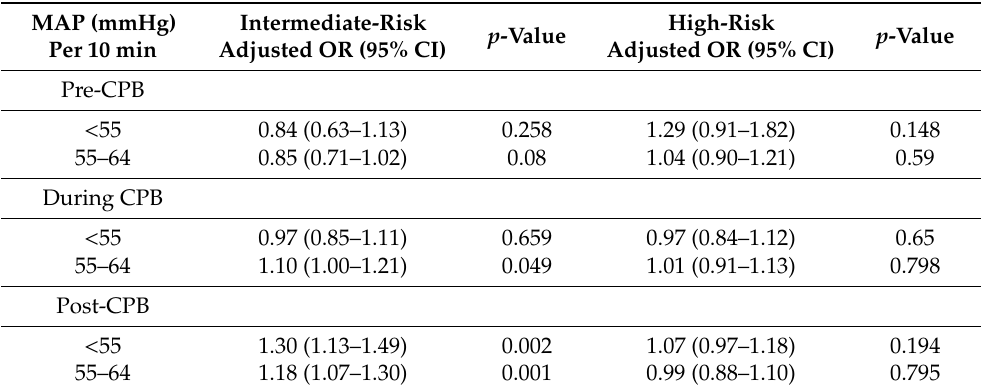
Table 5. Adjusted odds ratio of in-hospital mortality, stratified by preoperative